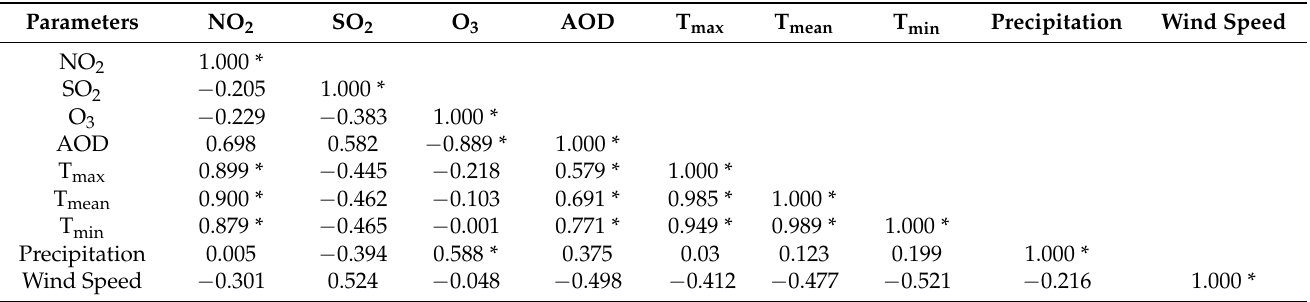
Table 4. Pearson Correlation association between air pollutants and climatic